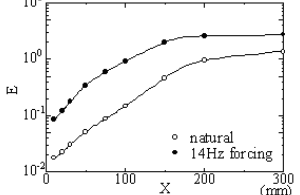
Fig. 14 Steamwise growth of integrated f 0 component E.